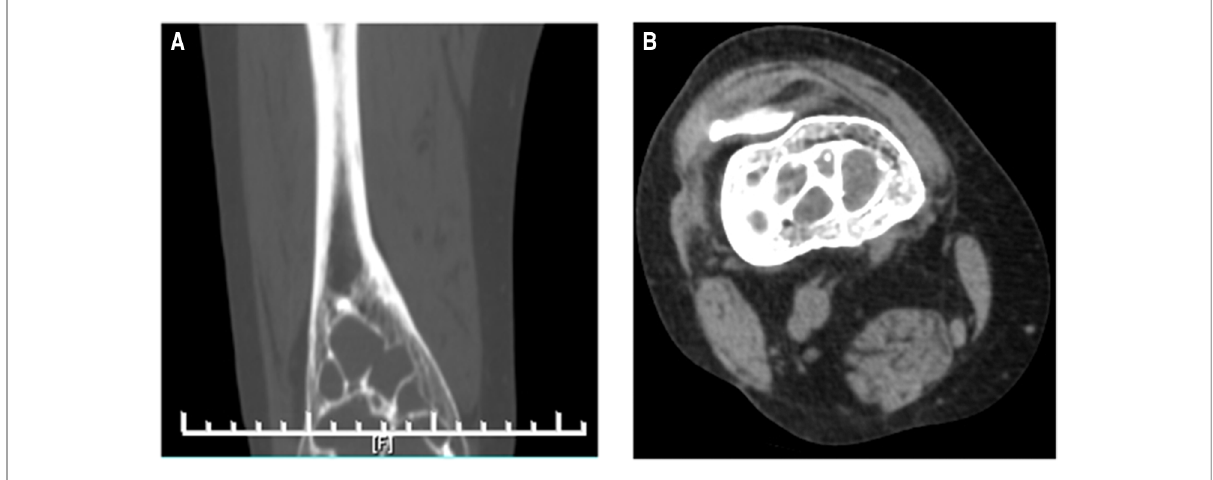
FIGURE 2 ( A ) preoperative forntal CT indicating that there were multiple cystic low-density shadows in the lower part of the right femur, with clear borders; ( B ) preoperative horizontal cross-sectional CT indicating that there were multiple cystic low-density shadows in the lower part of the right femur, with clear borders, sclerosis margins around, and no obvious abnormalities in adjacent soft tissues.